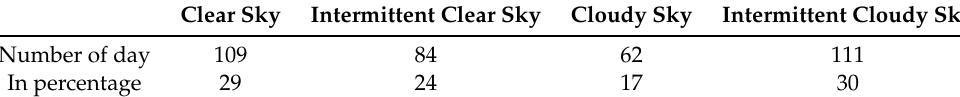
Table 4. Allocation of days according to their classes in 2012.